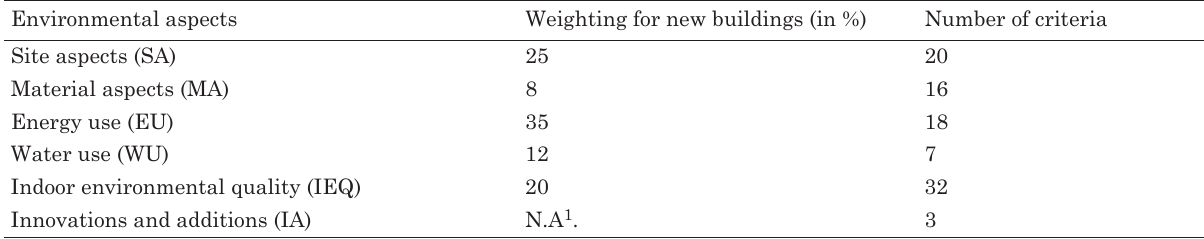
Table 1. Weightings of different environmental-related aspects in the overall grade of BEAM Plus certification Version 1.2